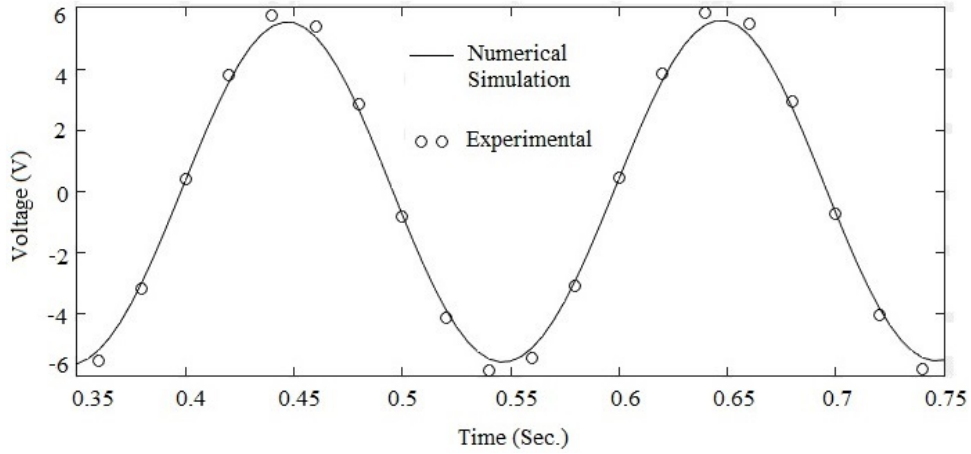
Figure 16. Voltage time waveform at 5 Hz.